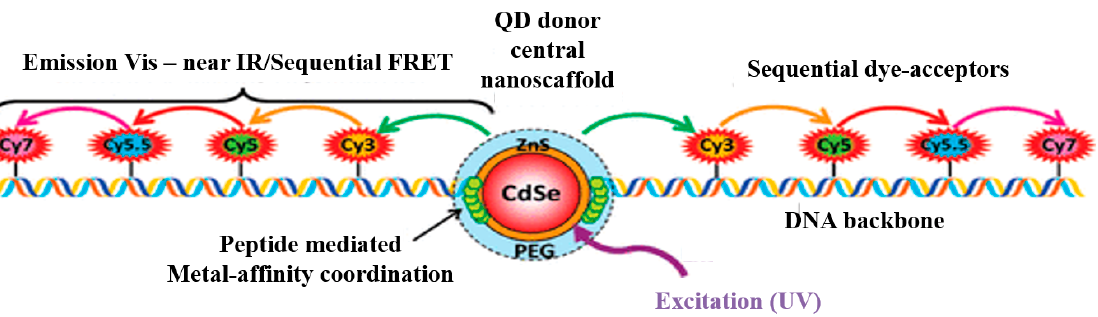
Figure 42. Schematics of DNA/peptide sequences and peptide–DNA chemoselective ligation [164].